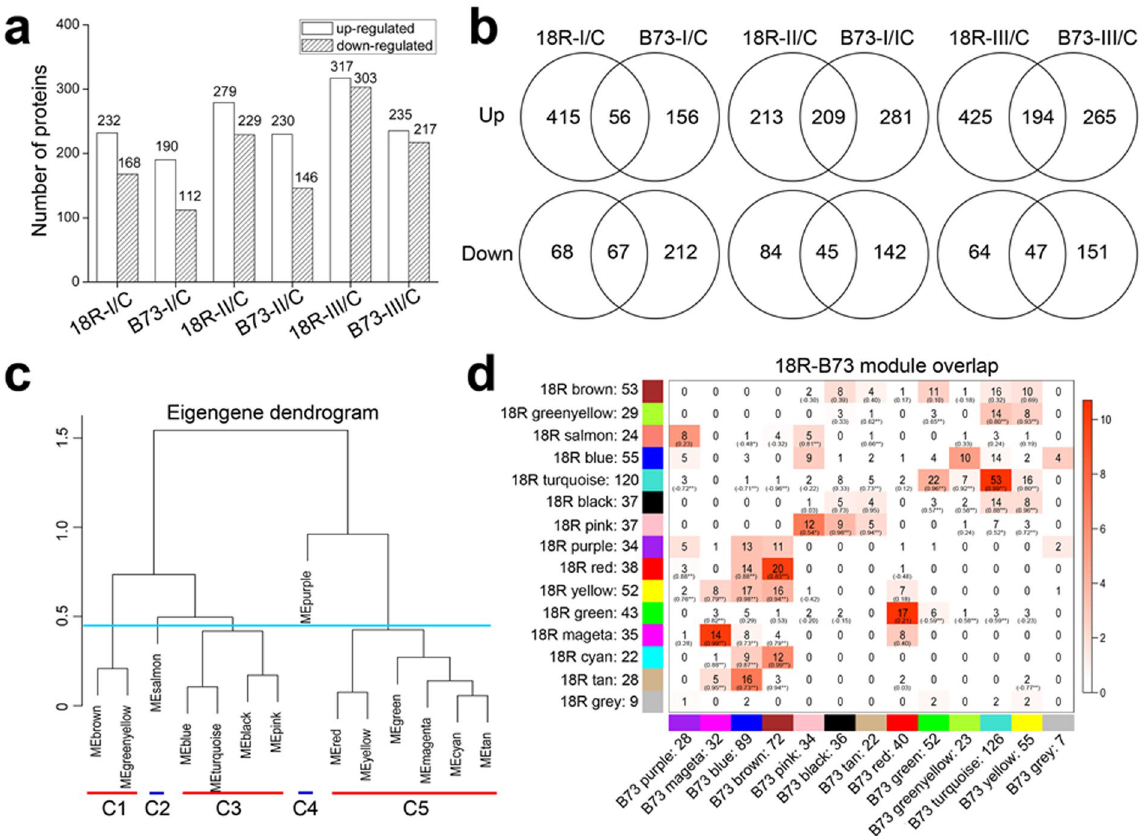
Figure 2. Overview of the maize proteomic response to induction medium and co-expression network analysis. ( a ) Numbers of differentially up- or down-regulated proteins (fold change > 1.5, P < 0.05) at each stage in 18R and B73. ( b ) Venn diagram of significantly up- and down-regulated proteins in 18R and B73 at each stage. ( c ) Eigengene dendrogram of modules based on the eigengene expression level of each module in 18R. The turquoise line points to the re-cluster dividing line. MEbrown and MEgreenyellow were re-clustered to cluster 1 (C1), as well as clustering C2 (MEsalmon), C3 (MEblue, MEturquoise, MEblack and MEpink), C4 (purple) and C5 (MEred, MEyellow, MEgreen, MEmagenta, MEcyan and MEtan). ( d ) Correspondence of 18R modules and B73 modules. Numbers in the table indicate protein counts at the intersection of the corresponding modules. Numbers in brackets represent the correlation coefficient of the module eigengene in the corresponding modules. * P < 0.05; ** P < 0.01. Coloring of the table represents the significance of the overlap of the two modules [log ( P ), Fisher’s exact